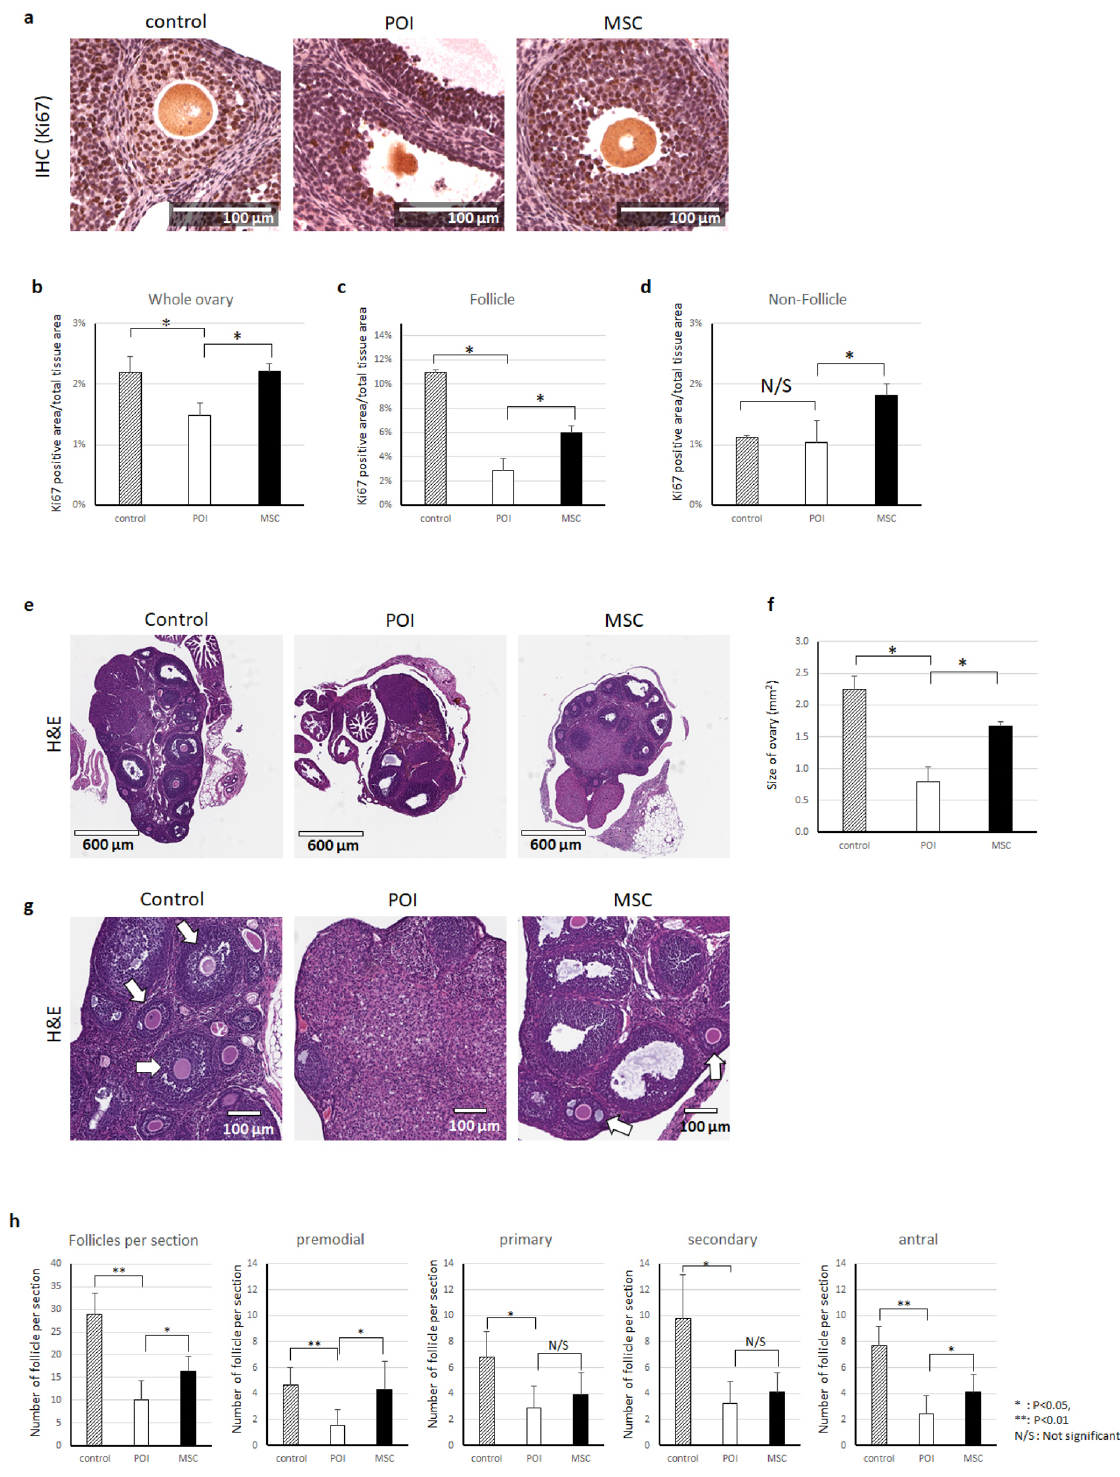
Figure 4. hMSCs restore proliferation in chemotherapy-induced POI ovaries. ( a ) Immunohistochemistry analysis for Ki67 in the ovary from a normal mouse (control), POI mouse (POI), and hMSC-injected POI mouse (MSC). ( b – d ) Comparison of Ki67-positive areas measured by immunohistochemistry. ( e ) Representative image of the whole ovary from a normal mouse (control), POI mouse (POI), and hMSC-injected POI mouse (MSC). ( f ) Comparison of the average size of the ovary in each group. ( g ) Representative images of ovarian follicles in each group. ( h ) Average number of follicles in each ovary slide between groups. Three ovaries from different animals were analyzed per group (* P < 0.05, ** P < 0.01, N/S not significant). Images taken and analyzed using Leica Aperio ImageScope version 12.4.0.5043 (https ://www.leica biosy stems .com/digit al-patho logy/manag e/aperi o-image scope